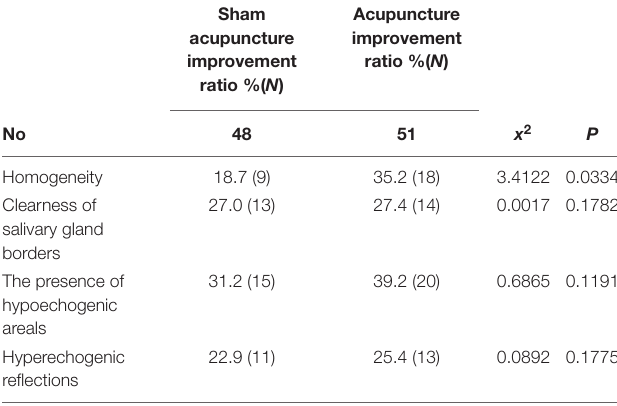
TABLE 7 | Improvement ratio in the ultrasonography of the salivary glands between week 0 and week 8.